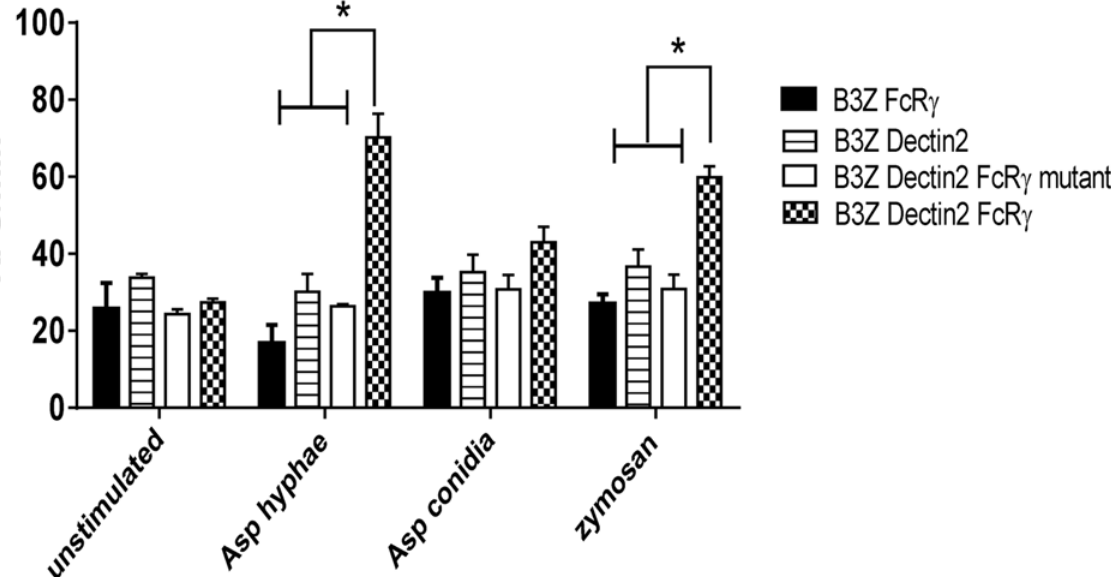
Fig 3. A . fumigatus hyphae trigger signaling responses by Dectin-2 and FcR γ cooperation. B3Z cells (2 × 10 5 ) containing a reporter plasmid for NFAT coupled to the β -galactosidase gene were transduced with WT FcR γ chain, Dectin-2, Dectin-2 and a signaling-deficient mutant of FcR γ chain Dectin-2 and WT FcR γ chain. Cells were either left unstimulated or stimulated with A . fumigatus hyphae (1 × 10 5 ), A . fumigatus conidia (1 × 10 5 ) or zymosan (100 μ g/ml). Fluorescence intensity, a reflection of NFAT activity, was measured at 5 min intervals for 1 hr. Data are means of RFU/min ± SD of duplicate wells and are representative of two independent experiments. * P <